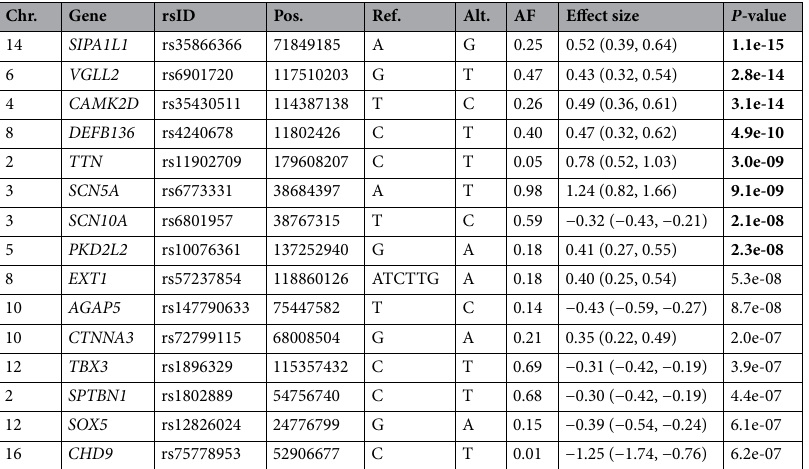
Table 2. Fifteen loci were found to be associated with delta age with at least suggestive significance 6 ( p ≤ 1 × 10 − ). The second column lists the protein-coding gene closest to the respective lead variant. Positions correspond to the GRCh37 human genome assembly 81 . Values in parentheses denote the lower and upper bounds of the 95% confidence interval of the effect size estimate. P -values with genome-wide 8 significance ( p ≤ 5 × 10 − ) are highlighted in bold. Chr., Chromosome; Pos., Position; Ref., Reference allele; Alt., Alternative allele; AF, frequency of the alternative